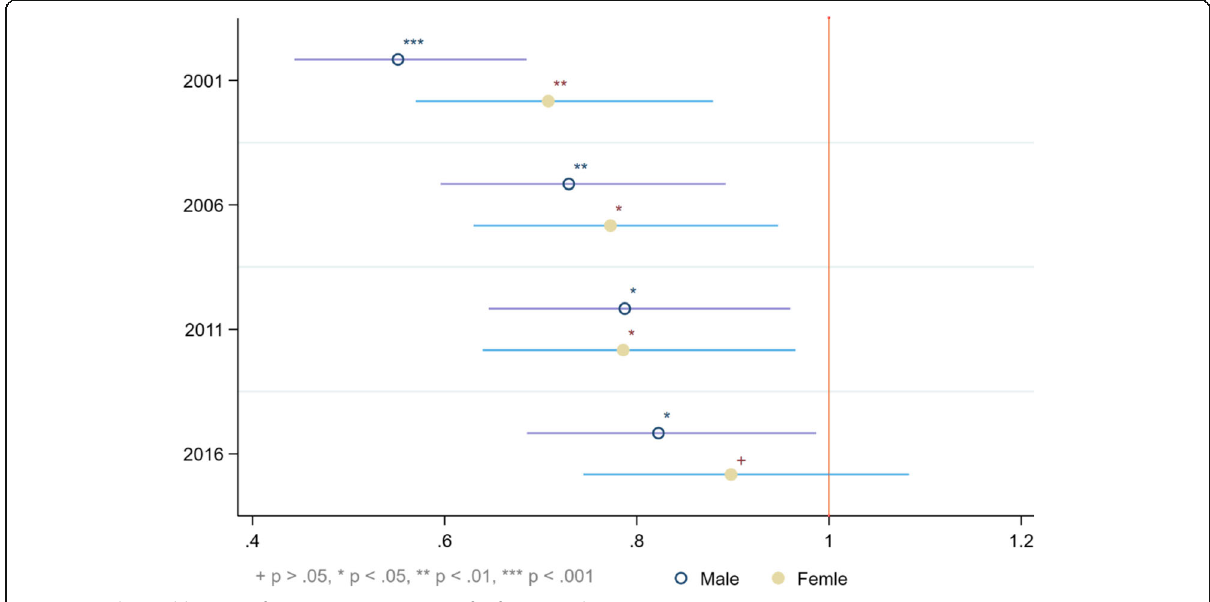
Fig. 4 Trends in odds ratios of not receiving treatment for fever/cough. 1995 –